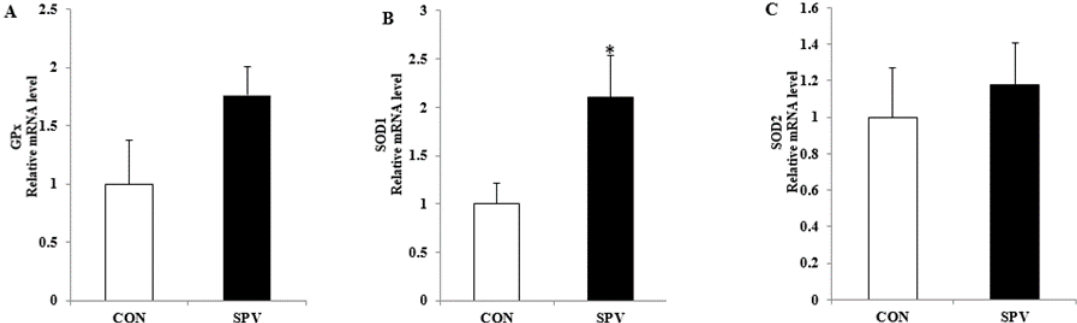
Figure 1. Effect of sweet potato vine supplementation on antioxidant stress relative genes’ mRNA expression in the granulosa cells ( n = 10). Data are presented as mean ± SEM. CON, gilts feed the basal diet; SPV, gilts fed basal diet with sweet potato vine. GPx , glutathione peroxidase; SOD1 , superoxide dismutase-1; SOD2 , superoxide dismutase-2. * p ≤ 0.05 .